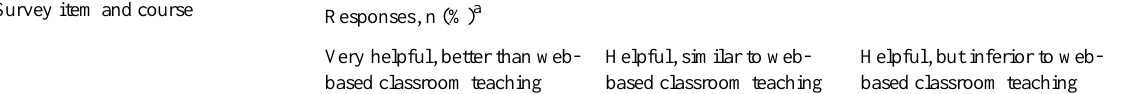
based classroom